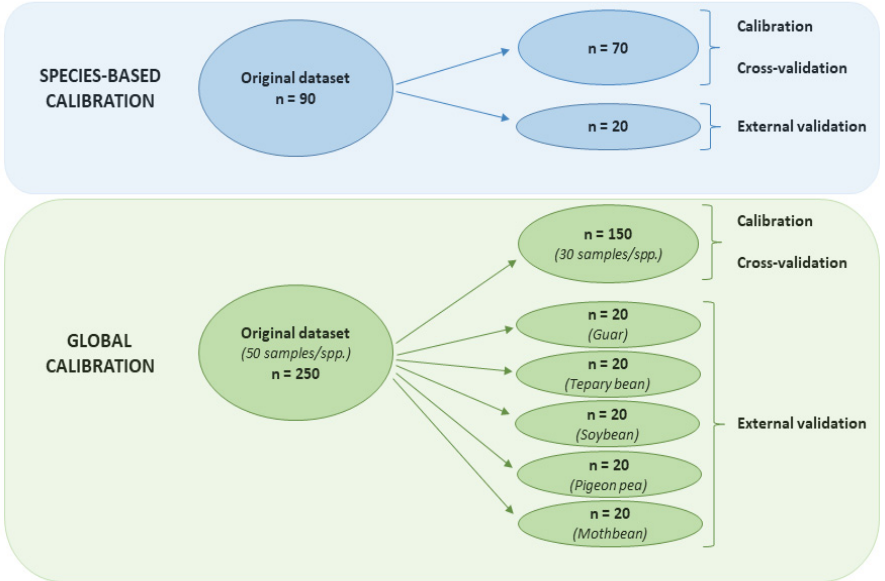
Figure 2. Diagram of the datasets, calibration, and di ff erent validation processes used in two calibration strategies.